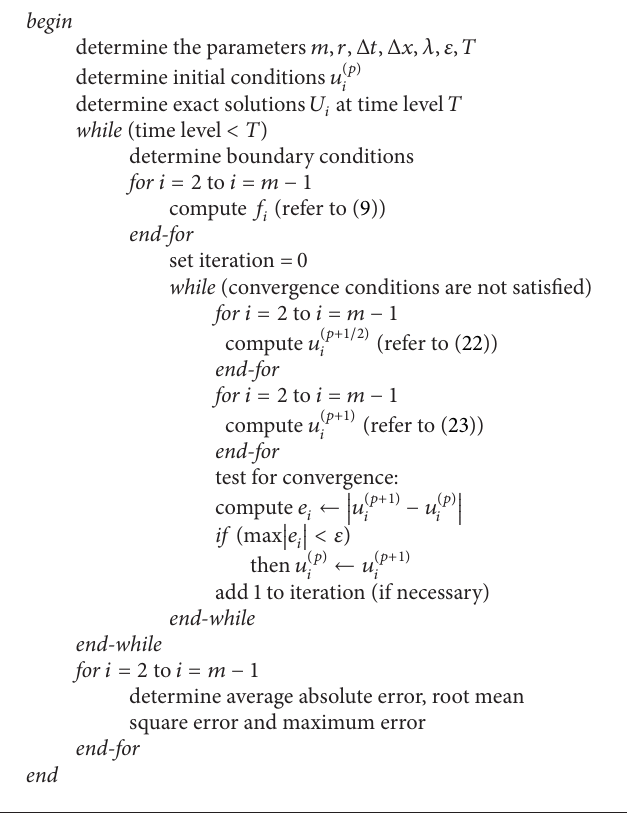
Algorithm 1: The IADEMF4 sequential